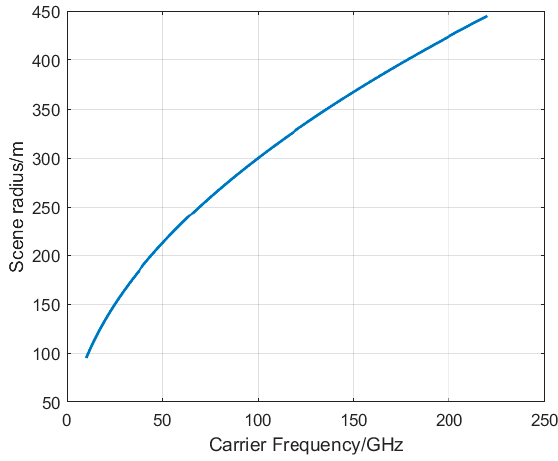
Figure 2. The relationship between scene radius and carrier frequency.